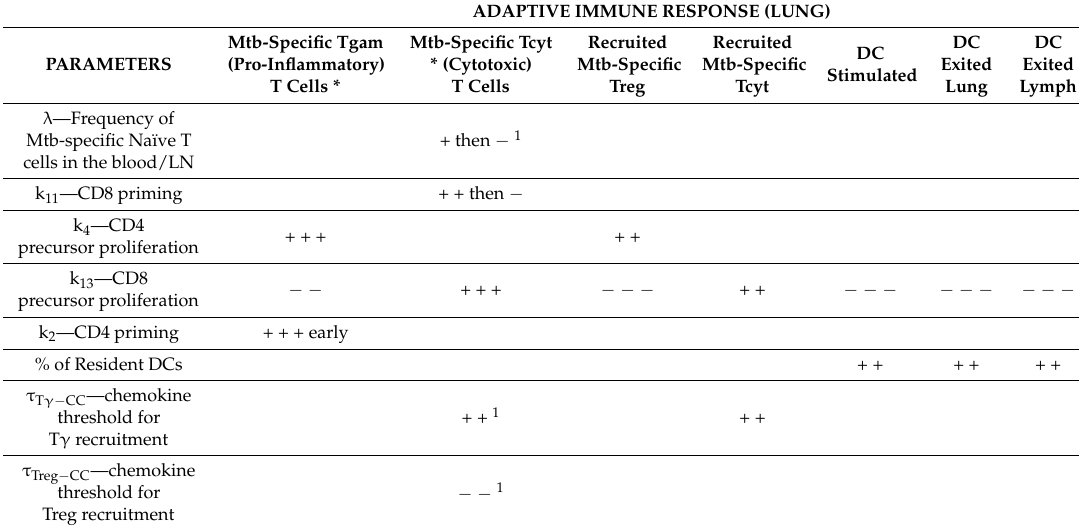
Significant PRCCs for blood adaptive immune response outcomes. List of all the parameters/mechanisms (rows) that have a significant (i.e., p < 10 − 3 ) PRCC with respect to outputs